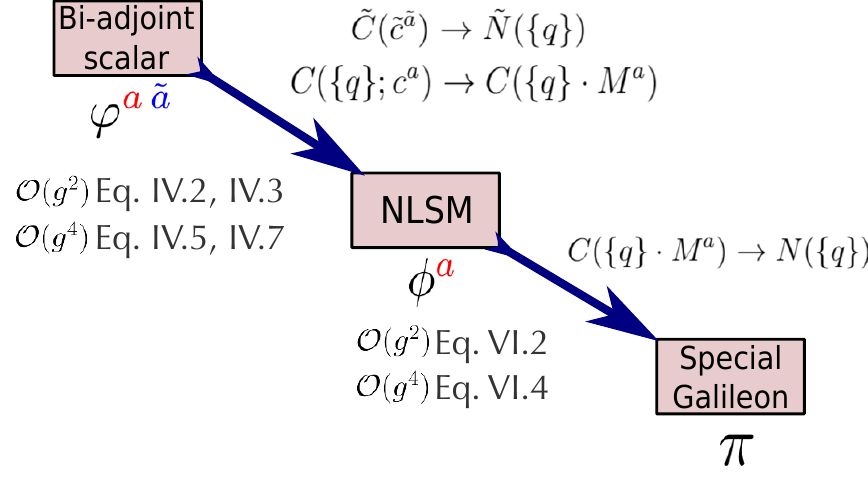
Figure 2 . Summary of color-kinematics replacements used in this